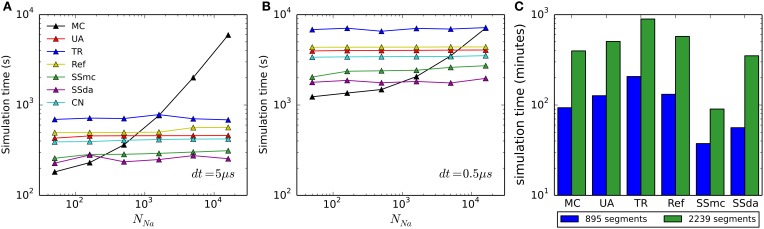
Computational cost of the simulation algorithms. (A,B) Real time needed to perform a 500-s current clamp simulation of the HH model with each algorithm and different numbers of channels, using an integration time step (dt) of 5 μs (A) or 0.5 μs (B). (C) Real time needed to perform a 2-s simulation of the full multi-compartment model, with an axon of length 1500 μm (blue) or 7500 μm (green). All simulations (single- and multi-compartment) were run in a 2.5 GHz AMD Opteron 6378 processor. Only one core was used for each simulation.